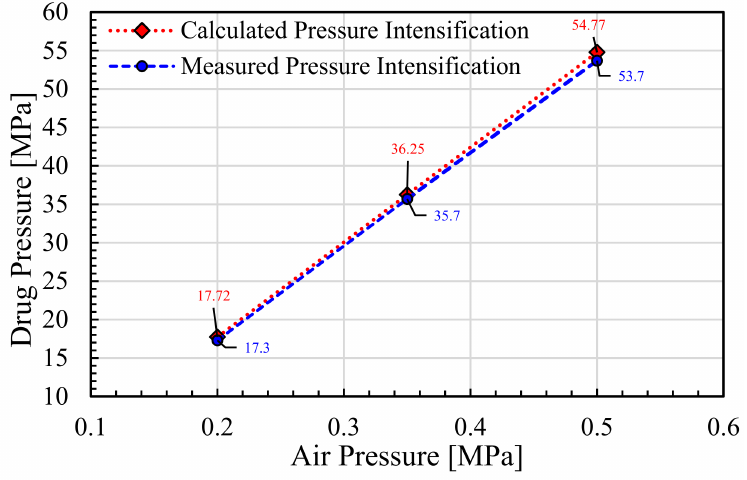
Figure 10. Pressure amplification results for the pressure intensifier of the